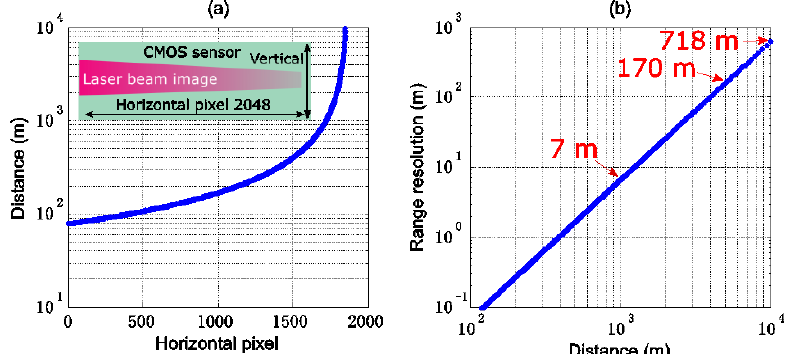
Figure 3. ( a ) Pixel-distance relationship, the inset figure shows a sketch of the laser beam image recorded by the CMOS sensor, a real laser beam image, measured by a Scheimpflug lidar system with an 800 mm focal length Newtonian telescope, is referred to Figure 7 in [30] ( b ) range resolution vs. measurement distance. Focal length: 750 mm, tilt angle 45°, pixel pitch 5.5 µm, number of horizontal measurement distance. Focal length: 750 mm, tilt angle 45 ◦ , pixel pitch 5.5 µ m, number of horizontal pixels 2048, transmitter-receiver separation 756 mm, distance of the calibration target 1308 m, and the pixel position of the backscattering signal from the calibration building is